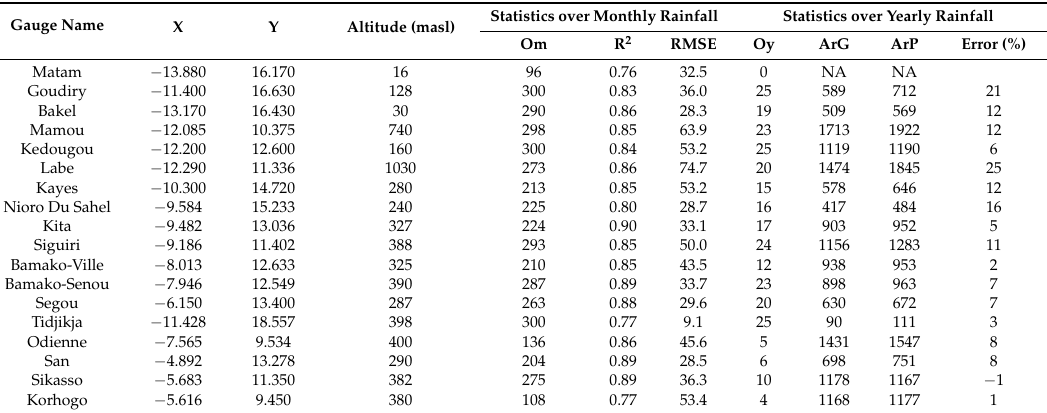
Table 2. Validation of PERSIANN-CDR rainfall.